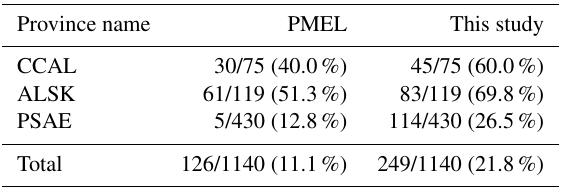
Table 2. Summertime DMS data coverage across the NESAP re- gion and within Longhurst provinces. Values indicate the number of data-containing 1 ◦ × 1 ◦ spatial bins out of the total number of bins within the given area (denoted by a slash), with percent cov- erage of area shown in parentheses. The left column represents the coverage for the PMEL data set (as utilized by L11), and the right column represents the updated data set containing both PMEL mea- surements and MIM-based DMS concentration